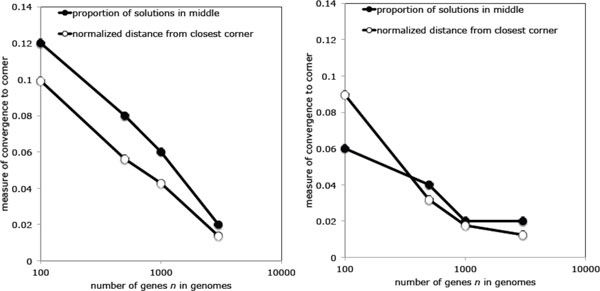
Median drift towards the corners and transience of the middle solution. Left: unsigned genomes. Right: signed genomes.